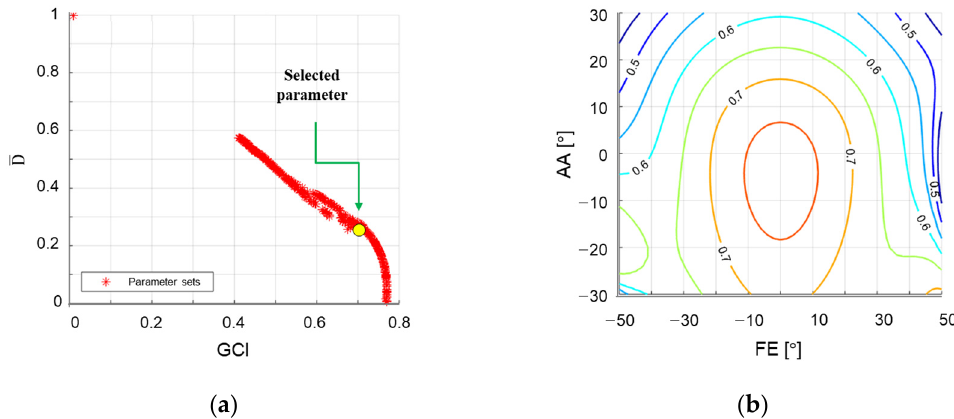
Figure 3. ( a ) The performance measures of the parameter sets after optimization. ( b ) Contour plot of LCI over the workspace. Since PS motion is independent of singularity, the contour plots are presented with respect to the other DOF. Each line is divided by 0.05. The minimum LCI over the workspace in ( b ) is 0.4.